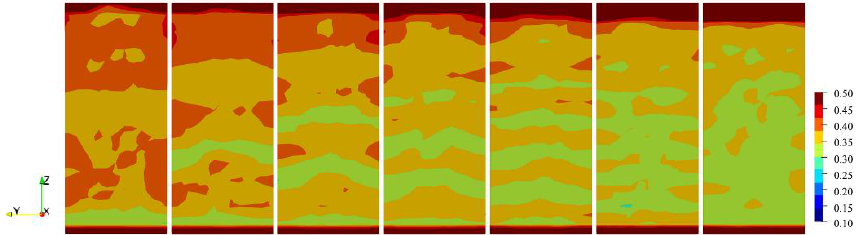
Figure 11. The cross-section of stock columns with a different number of layers for visualizing the void fraction’s distribution.